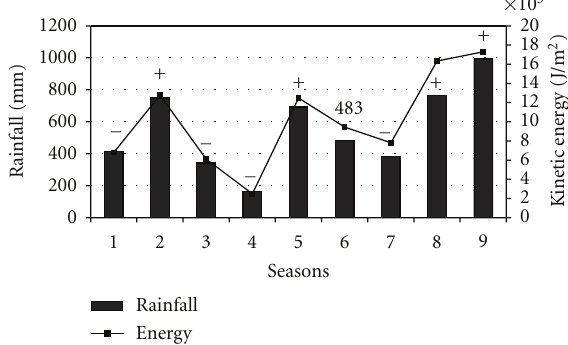
Figure 1: Seasonal rainfall energy and rainfall amount at Makoholi Contill site over nine